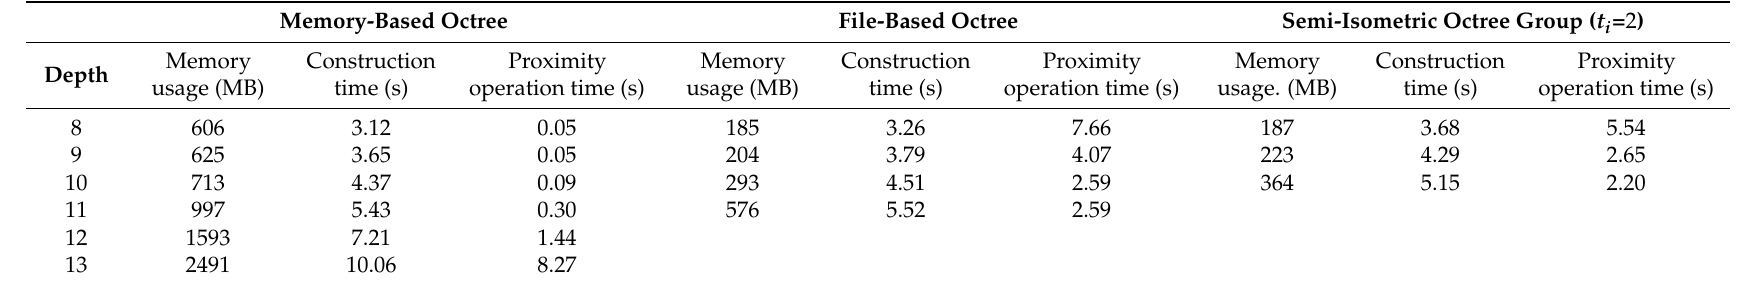
Table 8. Performance comparison among octree implementing methods using Data 2.